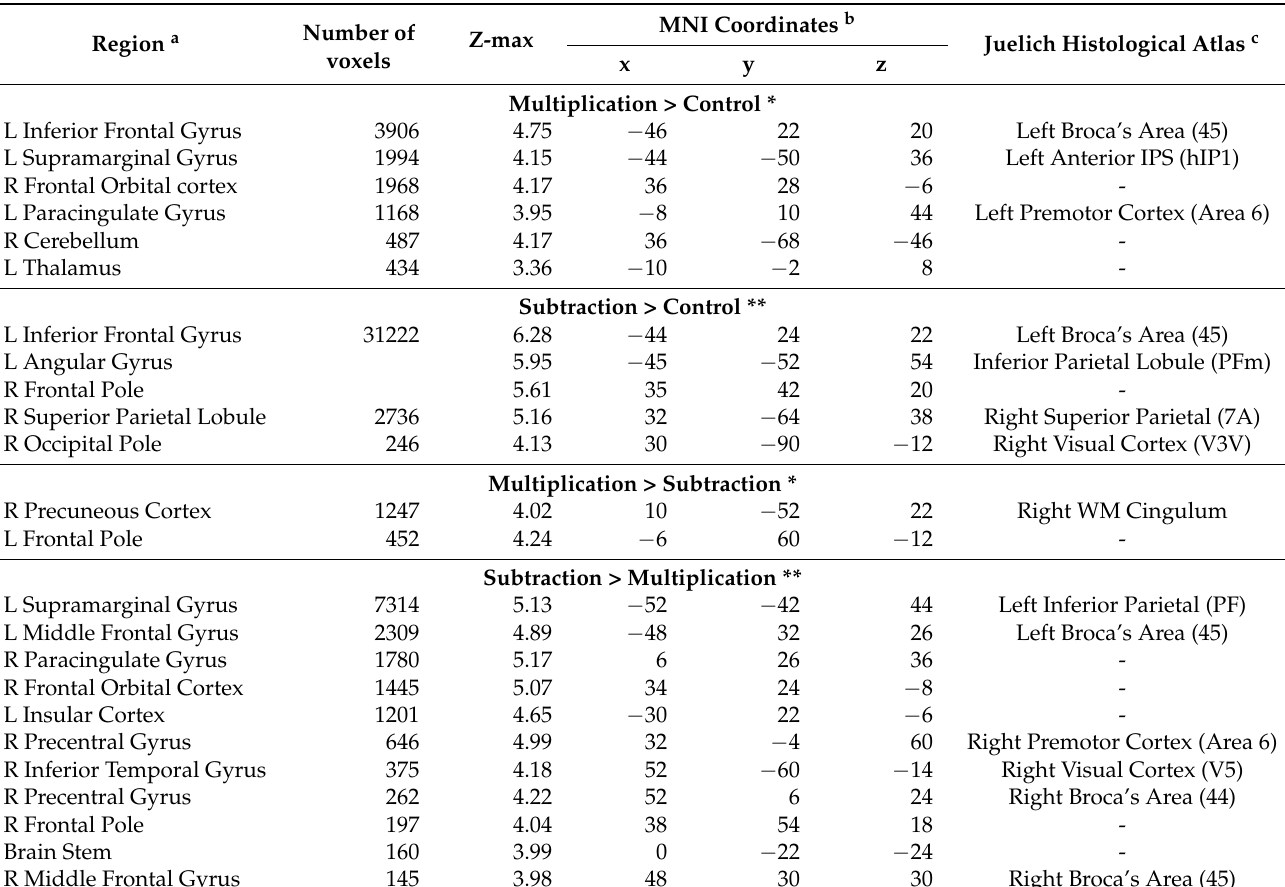
Table 3. Brain activations by contrast for the control